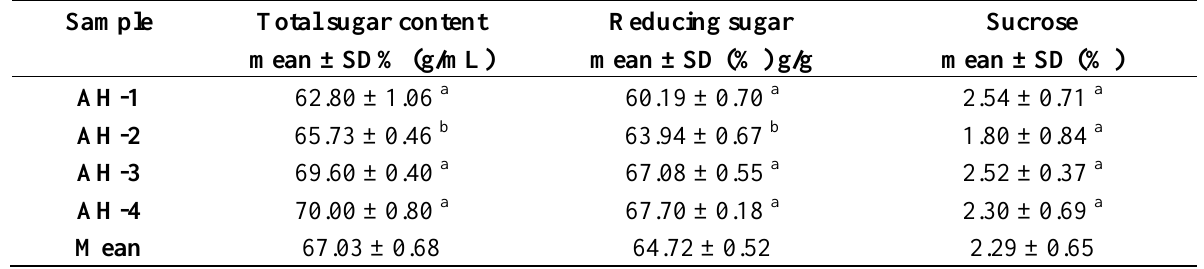
Table 2. Reducing and non-reducing sugar content of Algerian